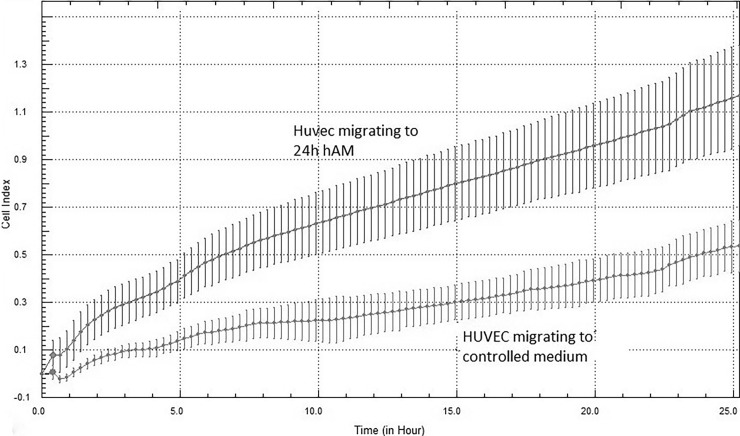
The example of real time migration assay of stimulated and controlled HUVECs directly from the X-Celligence system.The assay was repeated seven times with similar result during 25h observation at 37°C. The difference between migration curves for cells in cultures with presence of hAM CCM and in control medium was significant. (p < 0.05).